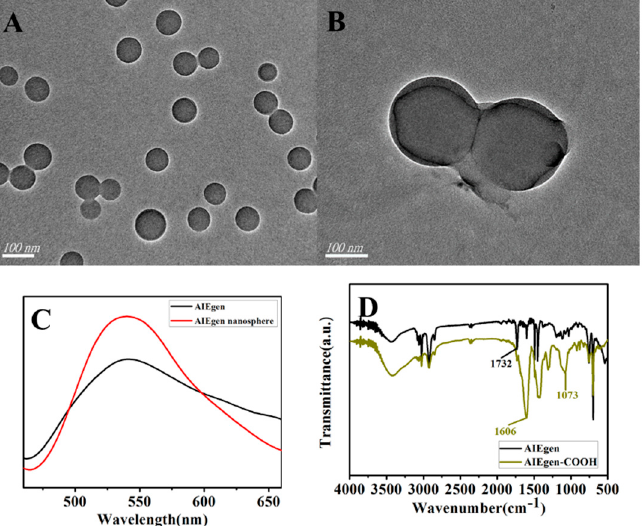
Figure 3. TEM and fluorescence spectra of AIEgen and AIEgen nanospheres as well as FT − IR spectra of carboxylated functionalized AIEgen. ( A ) and ( B ) show TEM diagrams of PS nanospheres and AIEgen nanospheres. ( C ) shows a comparison of the fluorescence spectra of AIEgen (DSAI) and AIE/PS assembled polymer. It can be seen from the figure that the fluorescence intensity of AIEgen assembled into PS nanospheres was enhanced. ( D ) shows the FT − IR spectrum of carboxyl functionalization of AIEgen. The peak at 1606 cm − 1 represents the formation of carboxyl functional groups; a strong, broad peak appears at 1073 cm − 1 .